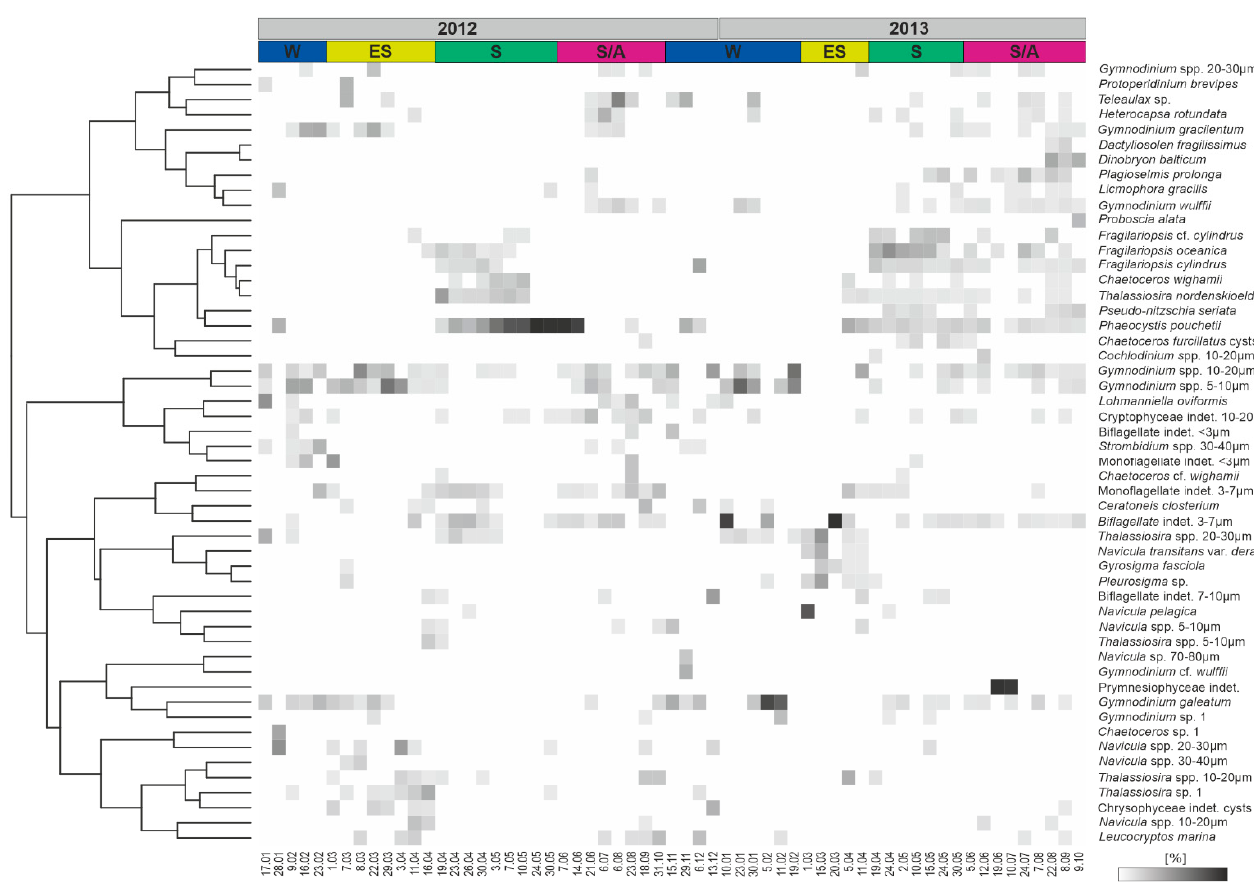
Figure 7. Heat map of taxa’s contribution [%] to the total abundance recorded at the IsA station in 2012 and 2013. Due to frequent references to the results of 2012 in the discussion, the previous year’s data are also shown. Abbreviations: W − winter, ES − early spring, S − spring, S/A − summer/autumn.